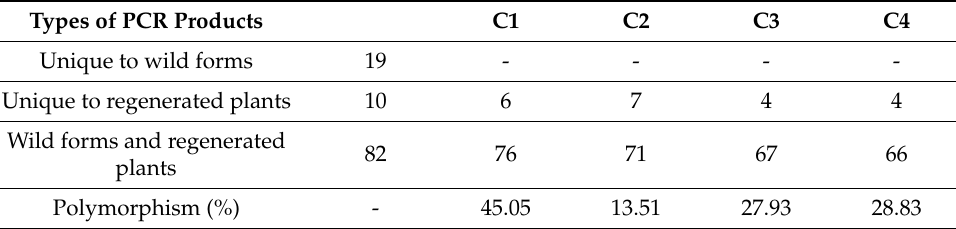
Table 5. Numbers of ISSR products according to groups of